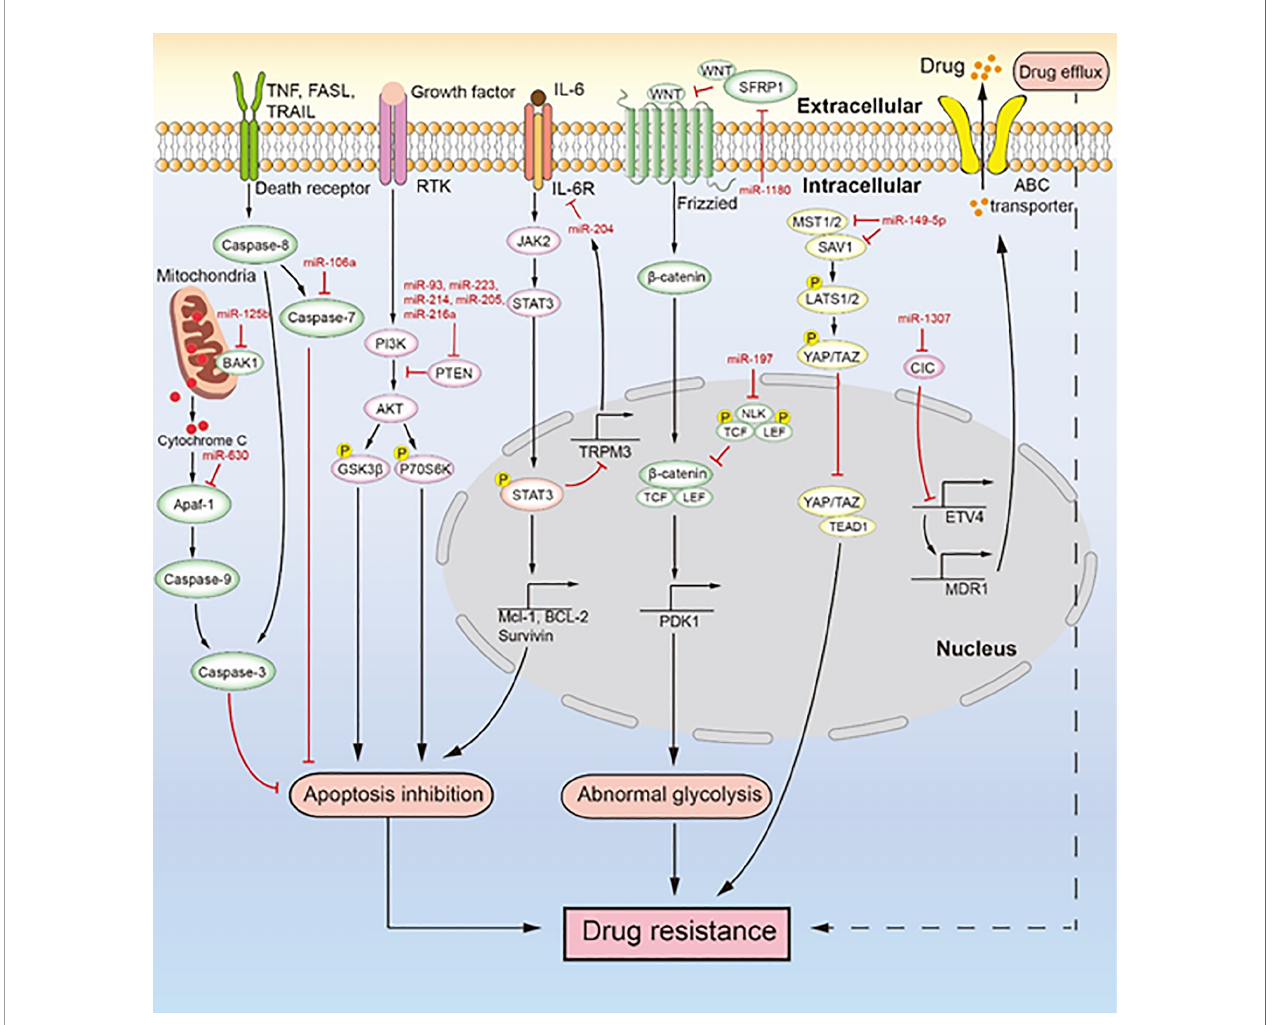
FIGURE 3 | MiRNAs mediate chemotherapeutic resistance by multiple signaling pathways. Multiple miRNAs lead to drug resistance by inducing drug ef fl ux, apoptosis inhibition, and abnormal glycolysis. MiR-106a, miR-630, and miR-125b inhibit apoptosis to induce drug resistance. MiR-93, miR-223, miR-214, miR-205, and miR-216a regulate the PI3K/AKT signaling pathway to inhibit apoptosis, which induces drug resistance. The IL-6/STAT3/miR-204 feedback loop inhibits apoptosis to promote drug resistance. MiR-1180 and miR-197 act via the Wnt signaling pathway to promote drug resistance. MiR-149-5p regulates the expression of MST1/2 and SAV1 to facilitate drug resistance. MiR-1307 upregulates the expression of ABCB1 to promote drug